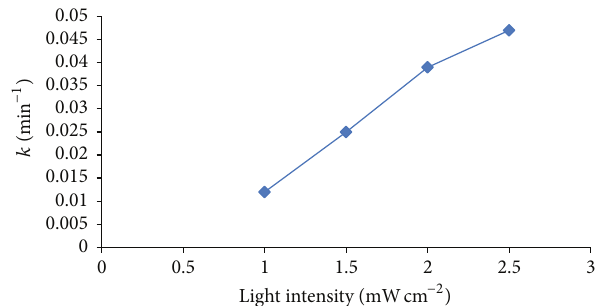
Figure 6: The effect of initial light intensity on the rate constant.